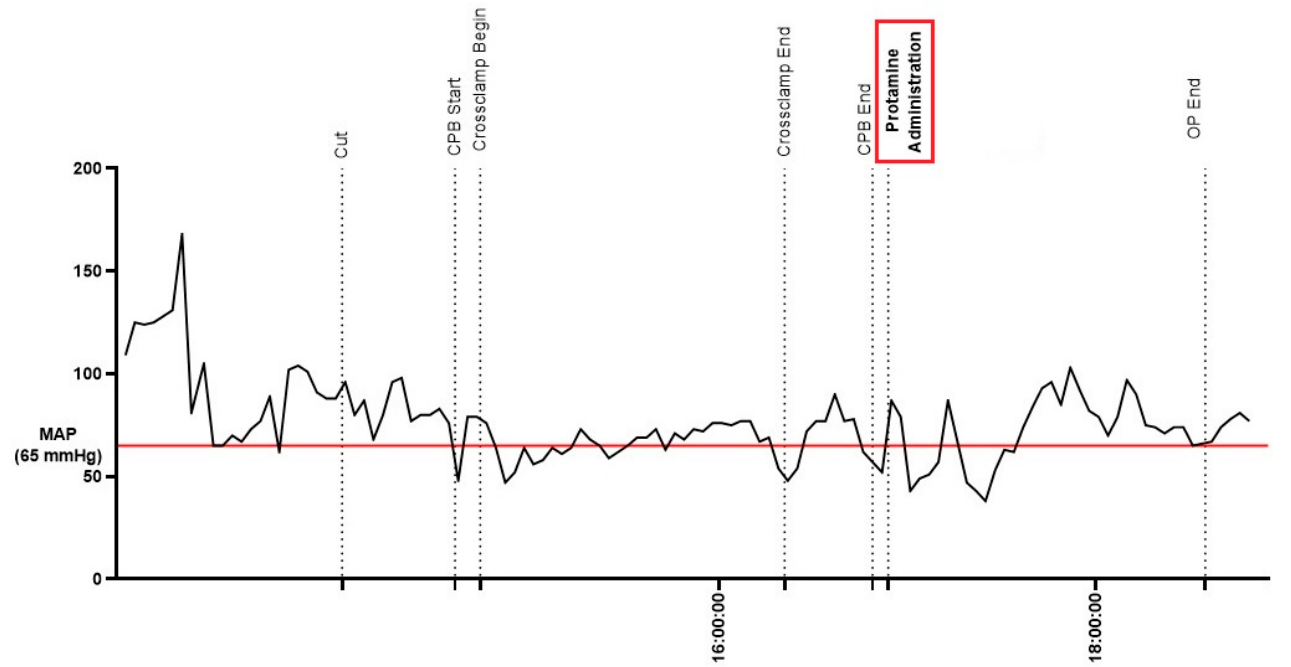
Figure 2. Hemodynamic follow-up during aortic valve replacement illustrating relevant event during surgery. A reference mean arterial pressure (MAP) was traced (red line), with a cutoff value of 65 mmHg.